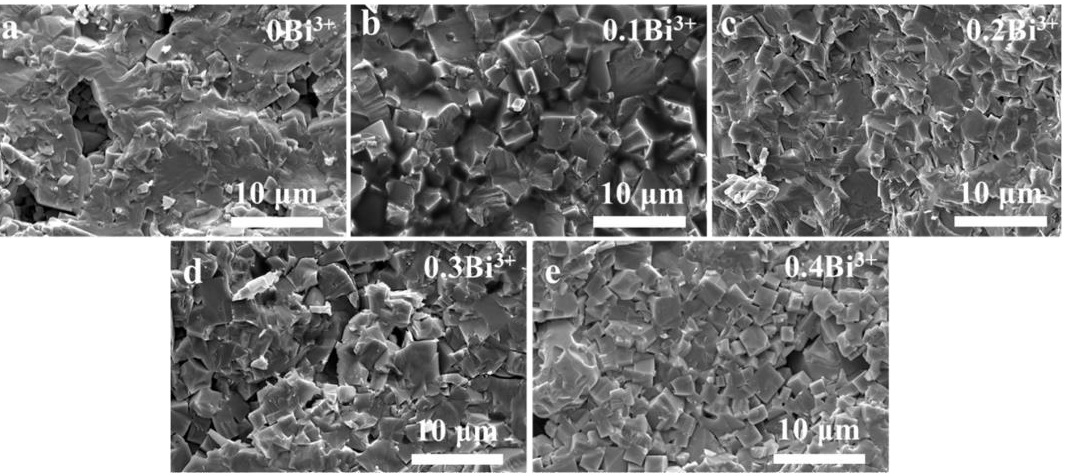
Figure 2. Top-view SEM images of Na 3 Zr 2 Si 2 PO 12 samples with different Bi 3+ concentrations: ( a ) zero, ( b ) 0.1, ( c ) 0.2, ( d ) 0.3 and ( e ) 0.4.